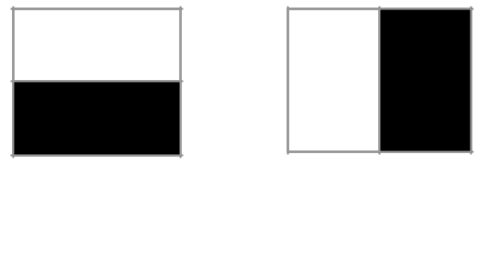
Figure 2: 2 Rectangle Feature